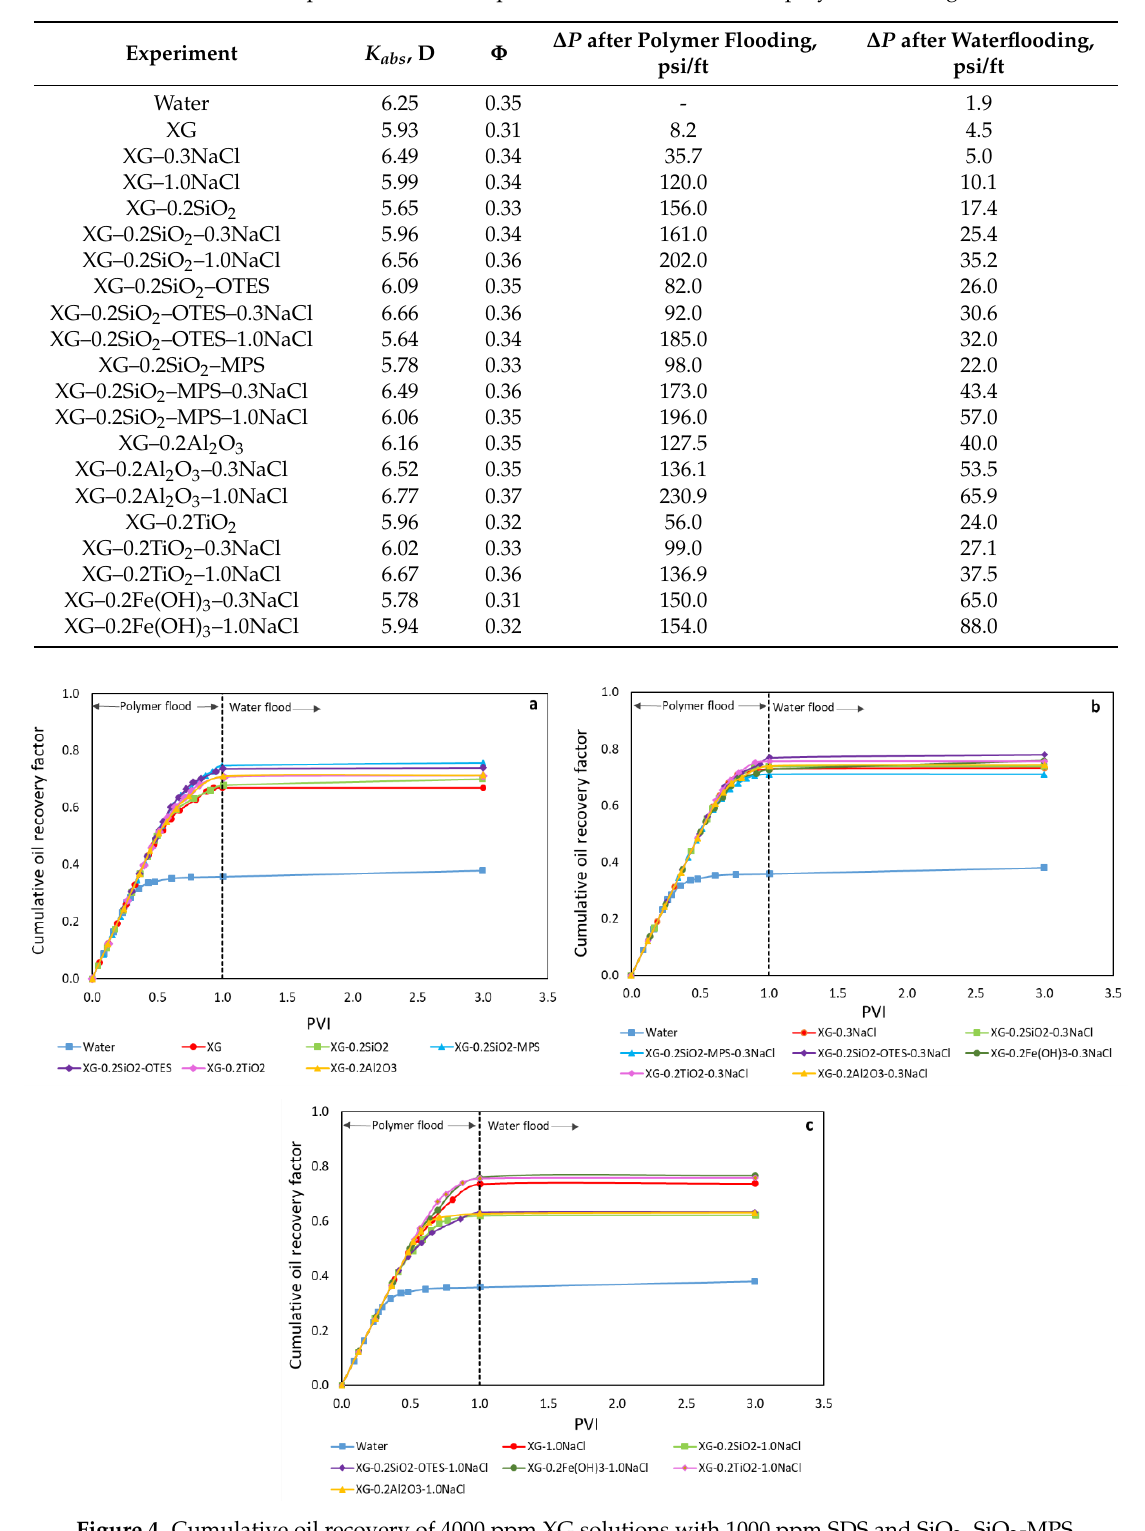
Figure 4. Cumulative oil recovery of 4000 ppm XG solutions with 1000 ppm SDS and SiO 2 , SiO 2 -MPS, SiO 2 -OTES, Al 2 O 3 , TiO 2 , and Fe(OH) 3 at a) 0 wt %, ( b ) 0.3 wt %, and ( c ) 1.0 wt % NaCl concentration at 25 °C.